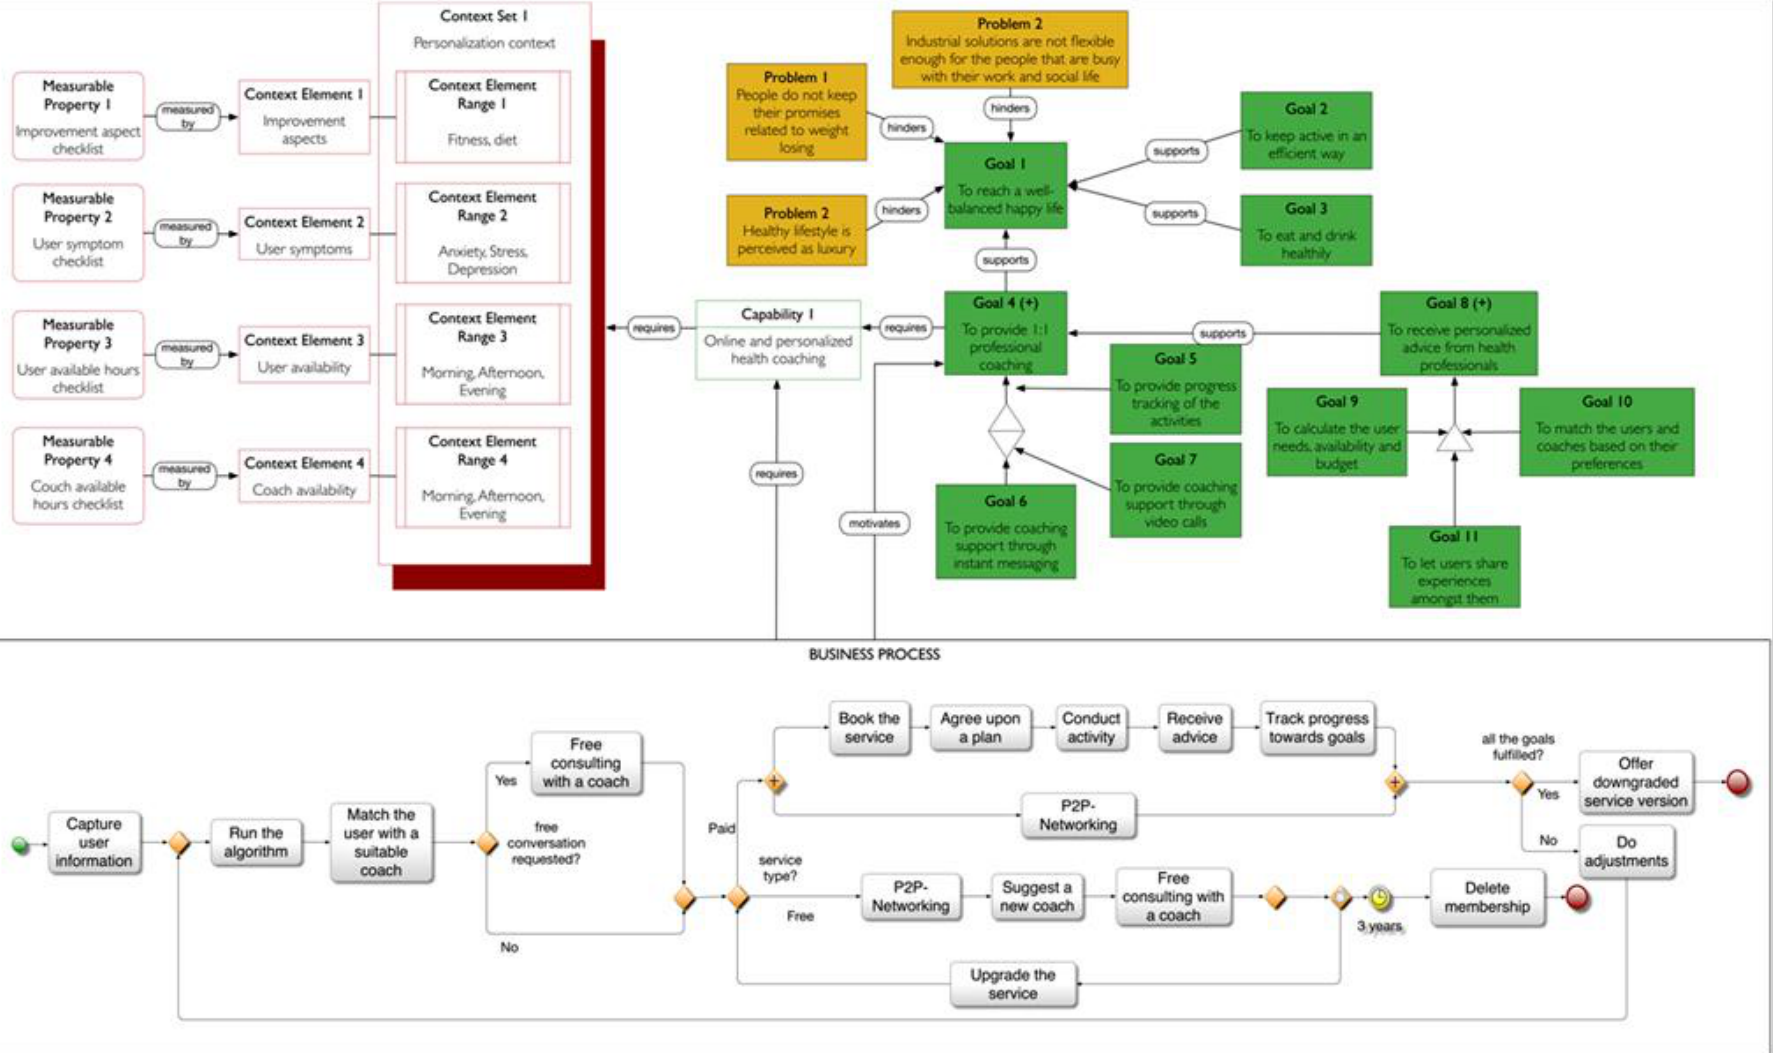
Figure 9. Capability model, including the goals, business processes, and the